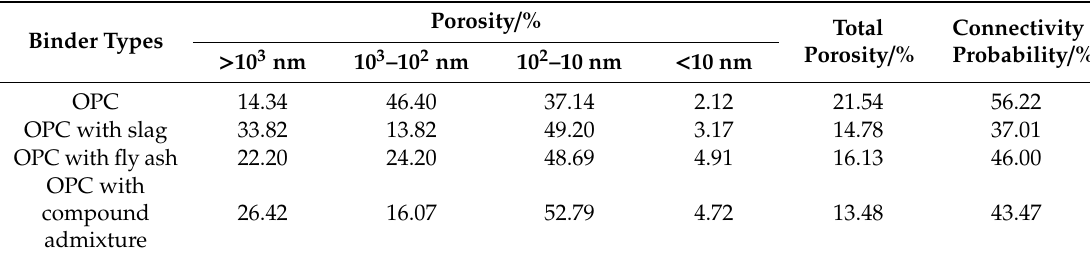
Table 5. Pore size distribution and connectivity probability of concrete.